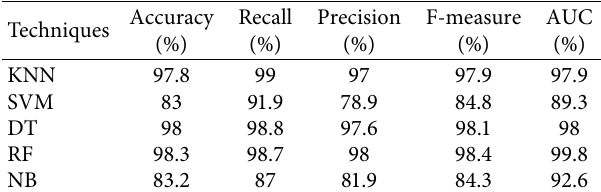
Table 8: Classification performance of applying boosting technique to selected features by PCA.